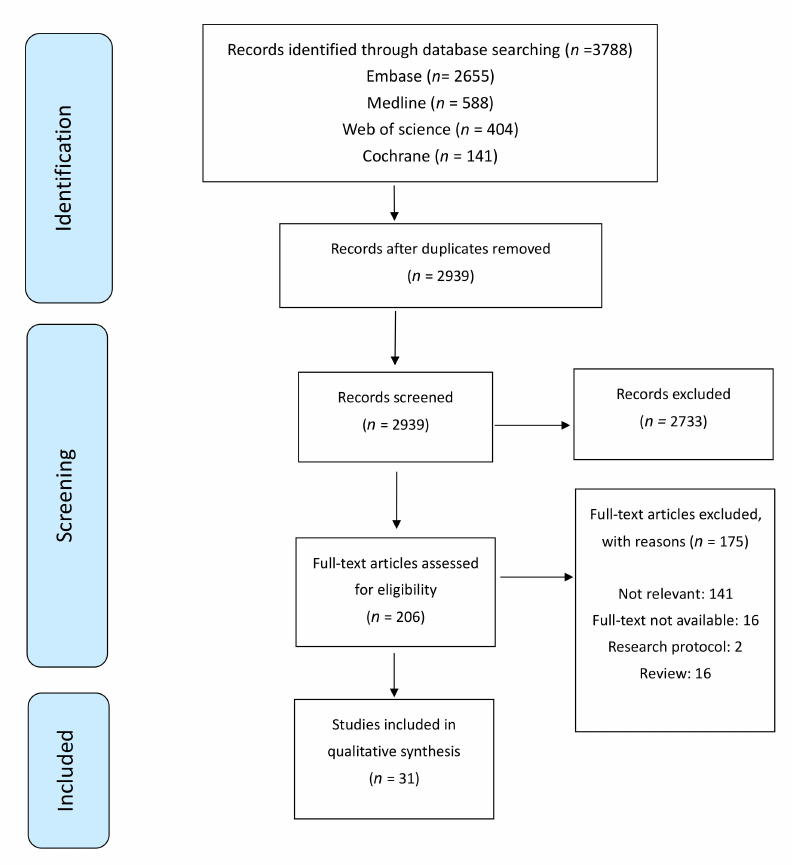
Figure 1. Flowchart for literature search